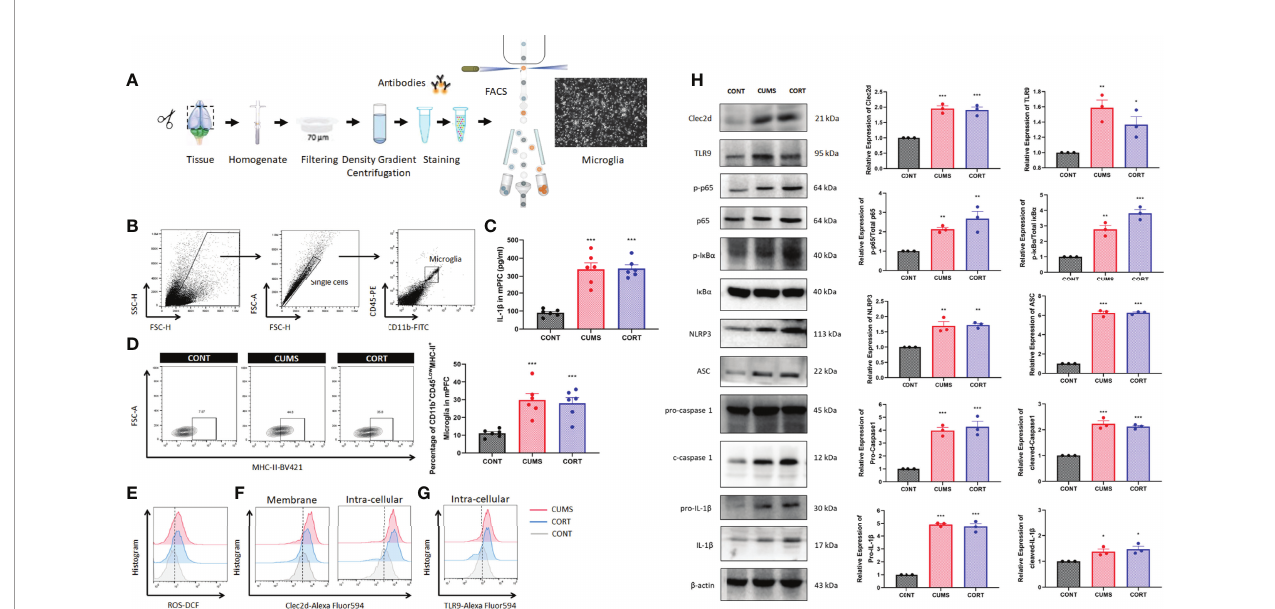
FIGURE 5 | Chronic stress induced microglial activation in mPFC. (A) Experimental protocol for FACS was presented. (B) Gate strategy for CD11b + 45 Low microglia was presented. (C) Concentration of IL-1 b in mPFC was measured (two-way ANOVA with Tukey ’ s post hoc test post hoc , *** P < 0.001, compared with CONT; n = 6). (D) Representative fl ow cytometry images showing the percentage of CD11b + CD45 Low MHC-II + microglia in mPFC of CONT, CUMS, and CORT groups, as well as the statistical analysis (two-way ANOVA with Tukey ’ s post hoc test post hoc , *** P < 0.001, compared with CONT; n = 6) were presented. (E) Representative histogram images showing CD11b + CD45 Low microglial ROS in mPFC were presented. (F) Representative histogram images showing CD11b + CD45 Low microglial Clec2d on the membrane and intracellular in mPFC were presented. (G) Representative histogram images showing CD11b + CD45 Low microglial intracellular TLR9 in mPFC were presented. (H) Representative Western blots showing microglial Clec2d, TLR9, NF- k B pathway, and NLRP3 in fl ammasome were presented. Relative expression of Clec2d, TLR9, p-p65, p-I k B a , NLRP3, ASC, pro-caspase-1, cleaved caspase-1, pro-IL-1 b , and cleaved IL-1 b was analyzed (two-way ANOVA